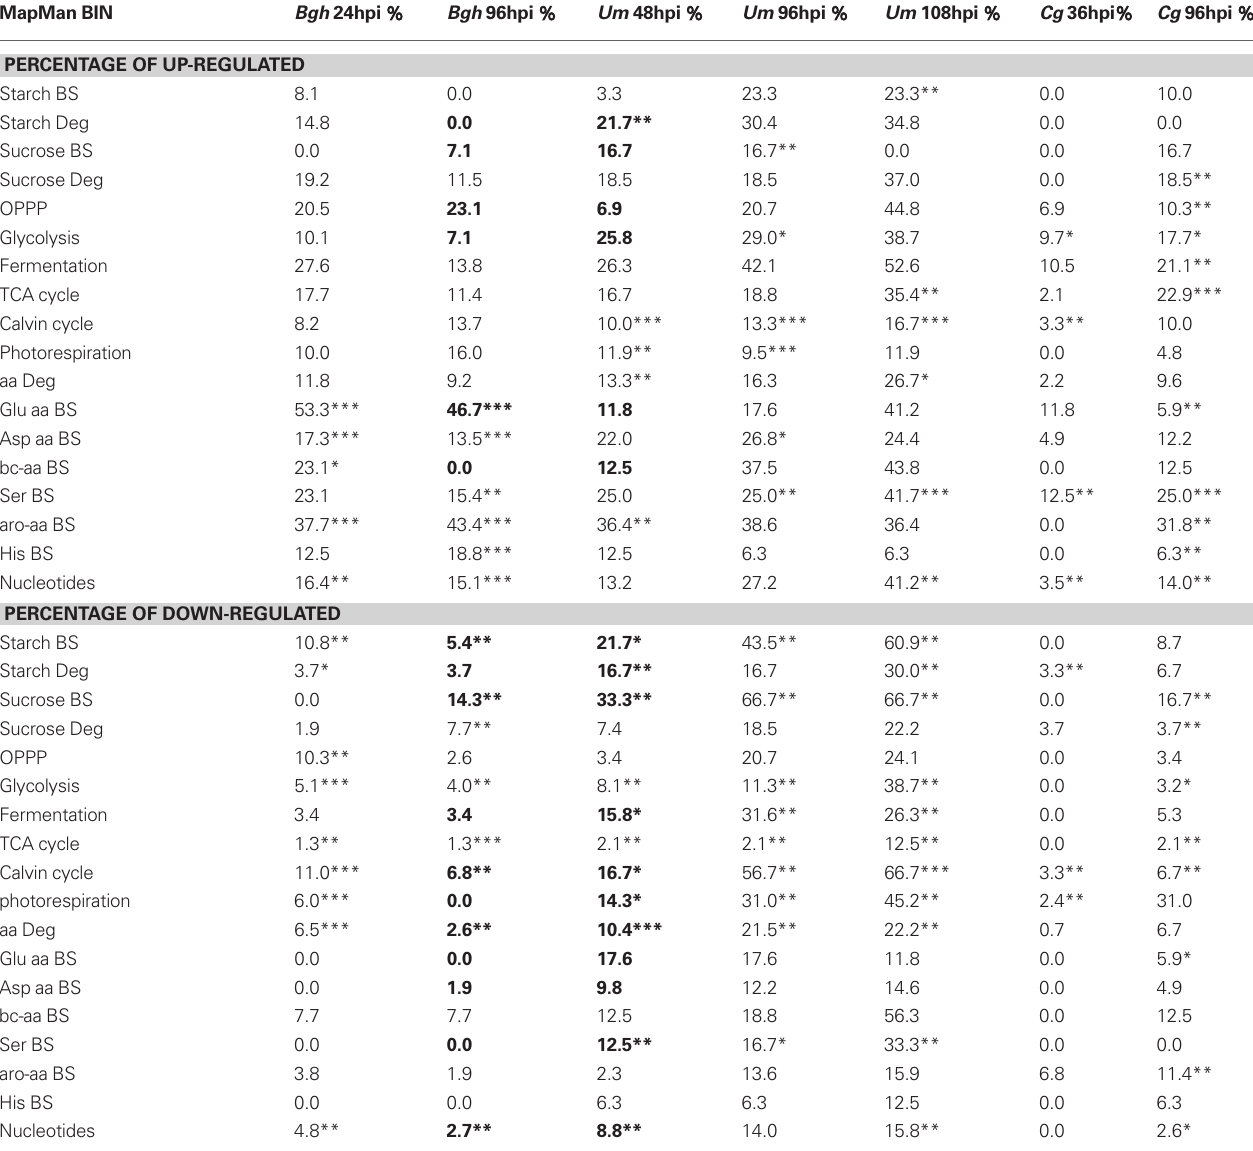
Table 3 | Percentage of up- and down-regulated genes in MapMan BiNs of central primary metabolism. MapMan